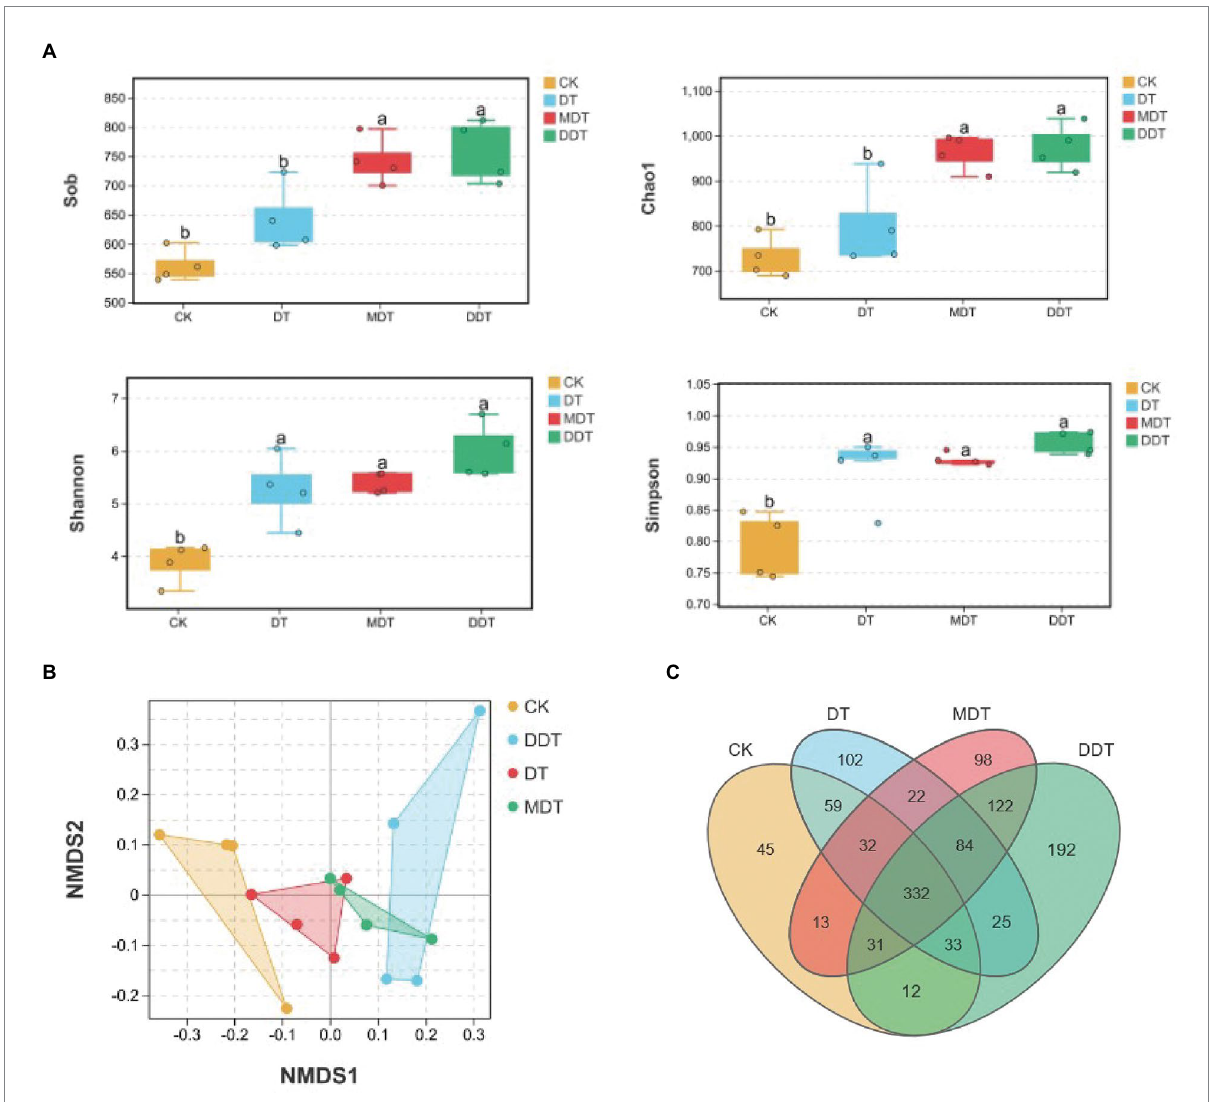
FIGURE 4 Rhizosphere soil fungal community diversity [ (A) α -diversity: Sob, Chao1, Shannon, Simpson; (B) β -diversity: NMDS)] and OTU number (C) under different